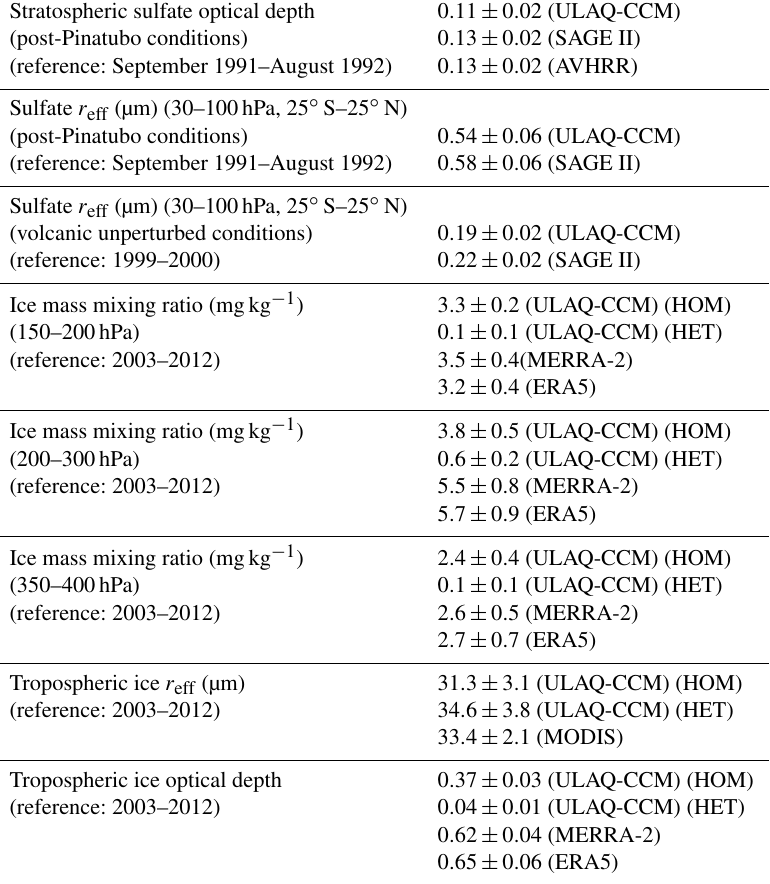
Table 2. Summary of globally and time-averaged sulfate aerosol and cirrus ice particle related quantities, as calculated in the ULAQ-CCM model and compared with available satellite and reanalyses data. Sulfate aerosols – sectional approach (Pitari et al., 2002, 2014). Cirrus ice particles: parameterization for homogenous (HOM) and heterogeneous (HET) freezing are summarized in the text and based on the formulation from Karcher and Lohmann (2002) (HOM), but including the effects of the aerosol size distribution, and Hendricks et al. (2011) (HET); a probabilistic approach is adopted for the ice supersaturation ratio. Standard deviations are calculated over the time series of globally averaged monthly mean values. On the global average, our model predicts a 90% fraction of the ice optical depth formed via homogeneous